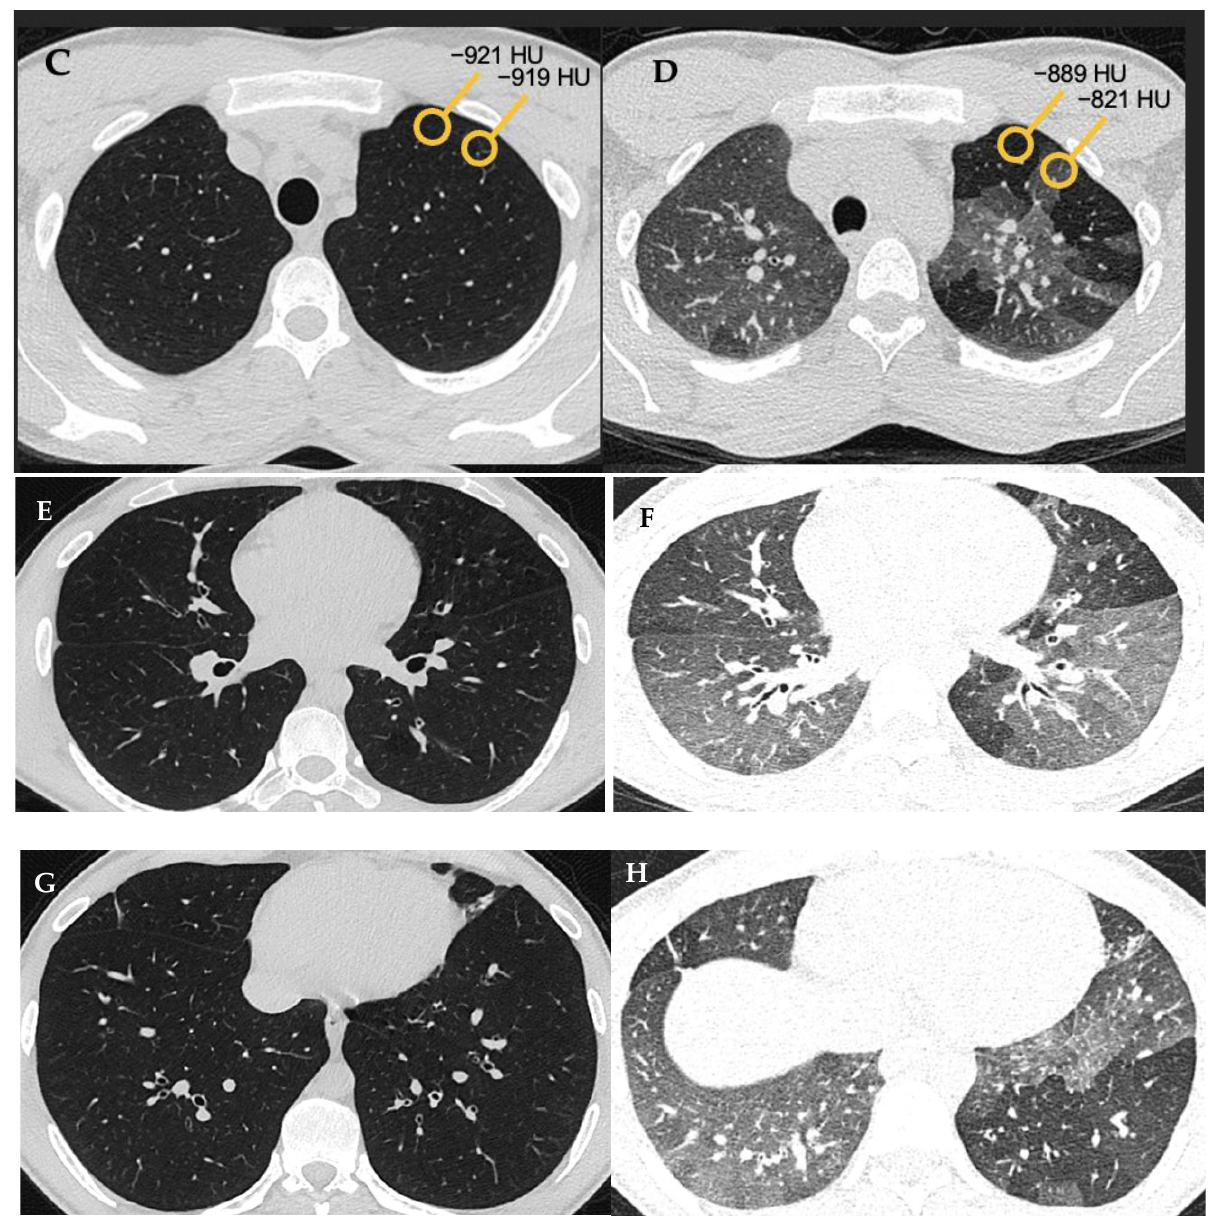
Figure 4. Air trapping ( A , B ). Axial inspiratory ( A , C , E , G ) and expiratory phase ( B , D , F , H ) CTs. On expiratory images the normal lung shows increase in the parenchymal density and decrease in volume. Interspersed geographic areas of air trapping lack the expected increase in density and volume reduction. Accentuated attenuation difference between areas of low and high density (32 versus 98 HU on image C and D respectively) indicates airway disease.